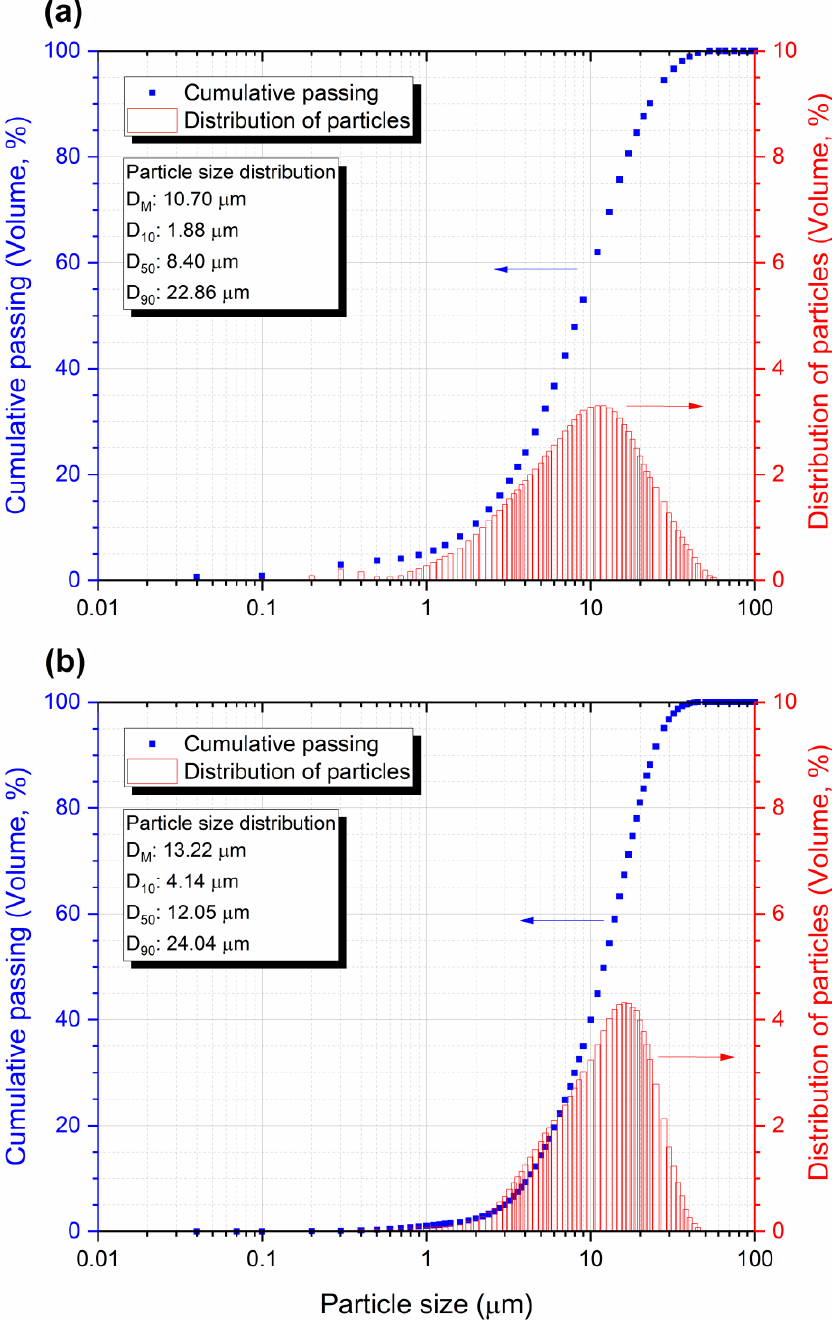
Figure 3. Particle size distribution curve with a histogram for ( a ) EBA and ( b ) SF.